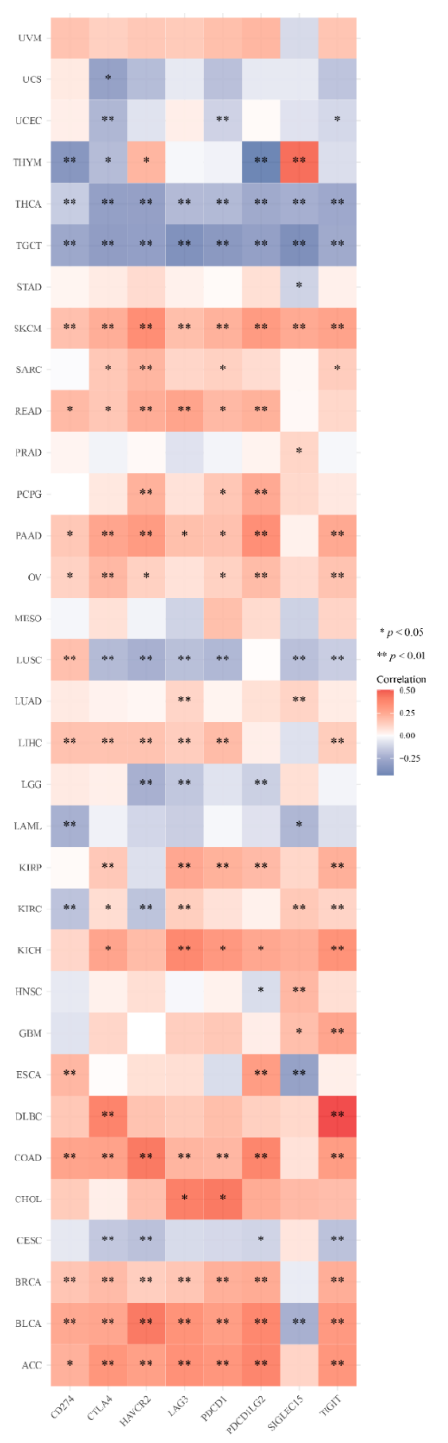
Figure 8. Expression of DMRT3 in the pan-cancer species was associated with the immune checkpoint genes. Heat map of the expression of the immune checkpoint-related genes in different tumor tissues, where the horizontal coordinates represent different immune checkpoint genes, the vertical coordinates represent different tumor tissues, and each box in the figure represents the correlation analysis between the expression of the DMRT3 gene and the expression of the immune checkpoint-related genes in the corresponding tumor, the different colors represent the changes in the correlation